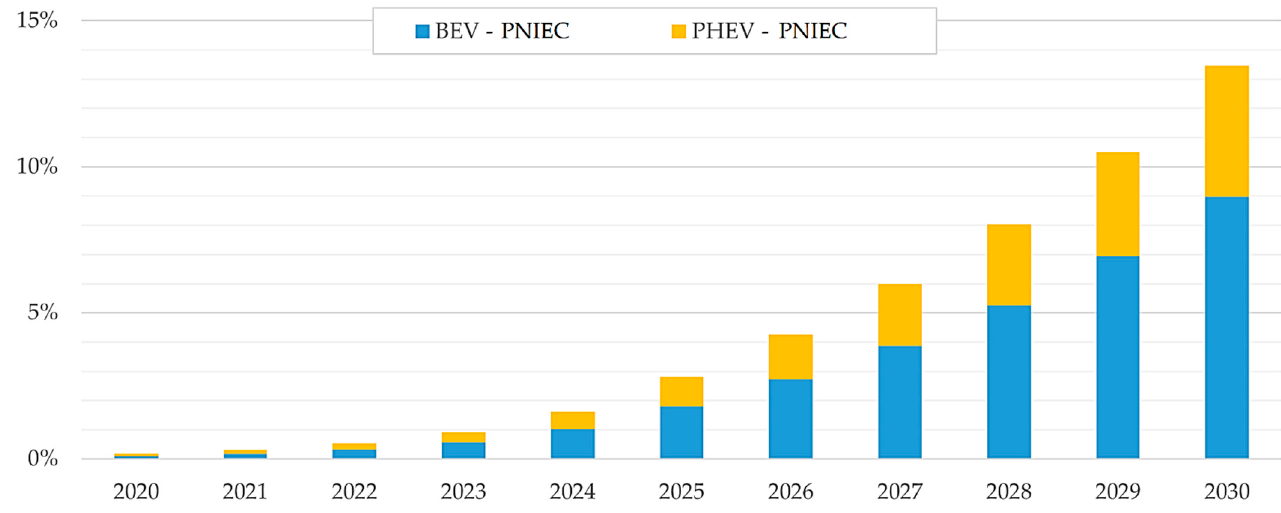
Figure 8. Estimated average BEV and PHEV penetration index on car stocks from 2020 to 2030 at Italian level (PNIEC scenario).